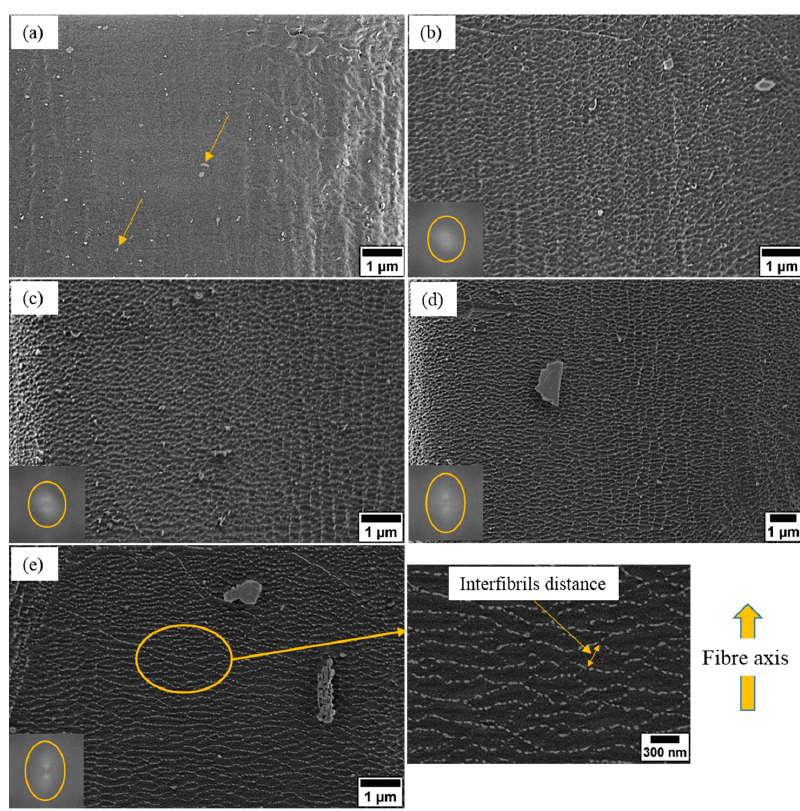
Figure 4. LV-SEM images of ramie fibers with their FFT images (bottom left) ( a ) untreated (yellow arrows point to impurities), and plasma treated for ( b ) 1, ( c ) 2, ( d ) 3, and ( e ) 4 min treatment duration with surface details marked by the yellow circle.